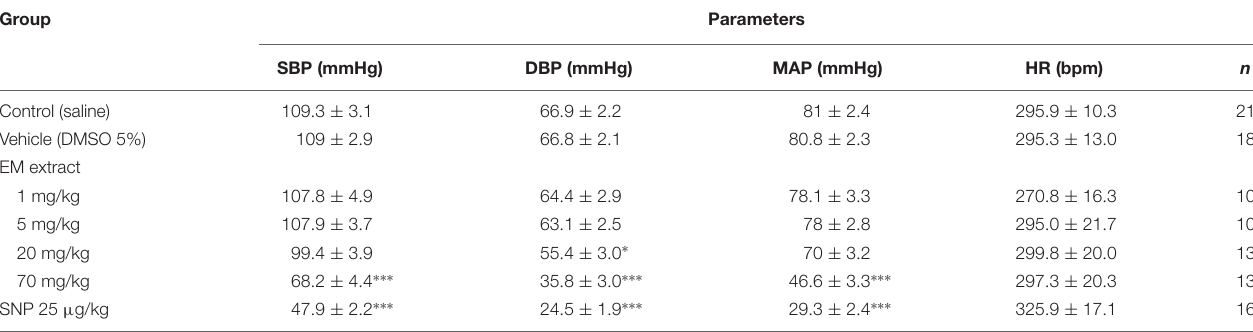
TABLE 2 | Acute effect of Eulophia macrobulbon (EM) extract on blood pressure in normotensive anesthetized rats.